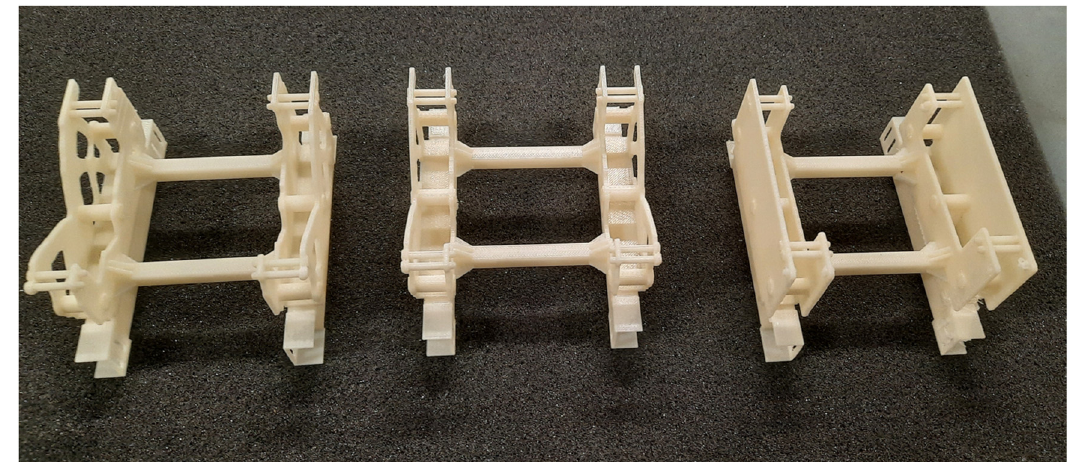
Figure 19: 3D - printed models of PS1 ( left ) , PS2 ( center ) , and the original fi xture adapter. The parts are printed as shown.